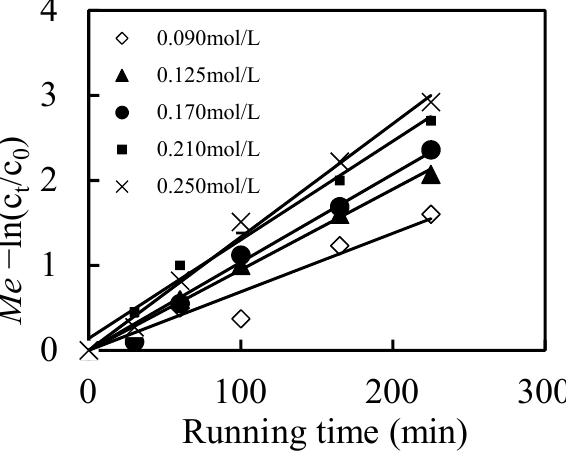
Figure 5. Effects of N-503 concentration on the migration efficiency ( Me ) of Mo(VI).